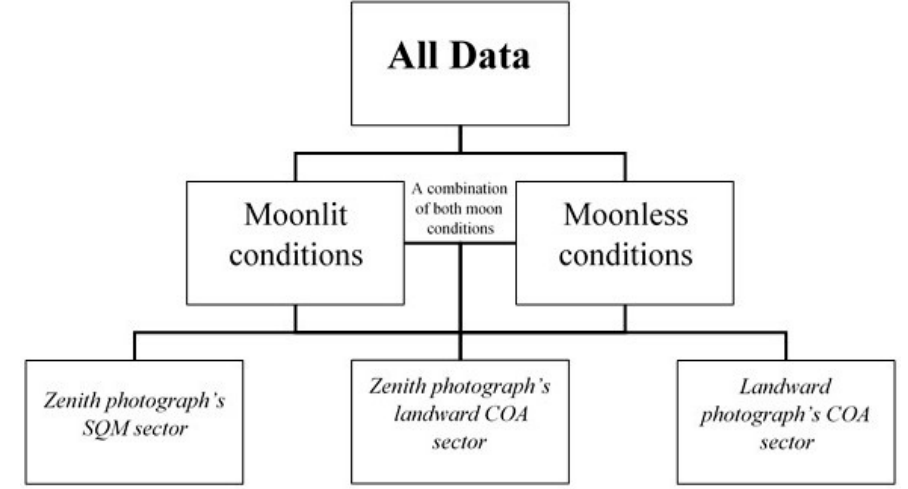
Figure 7. Flowchart of the differing conditions (moon presence, photograph type, and sector) in which the response variable (brightness) was measured, factors which dictated the construction of the backward stepwise multiple linear regression models.